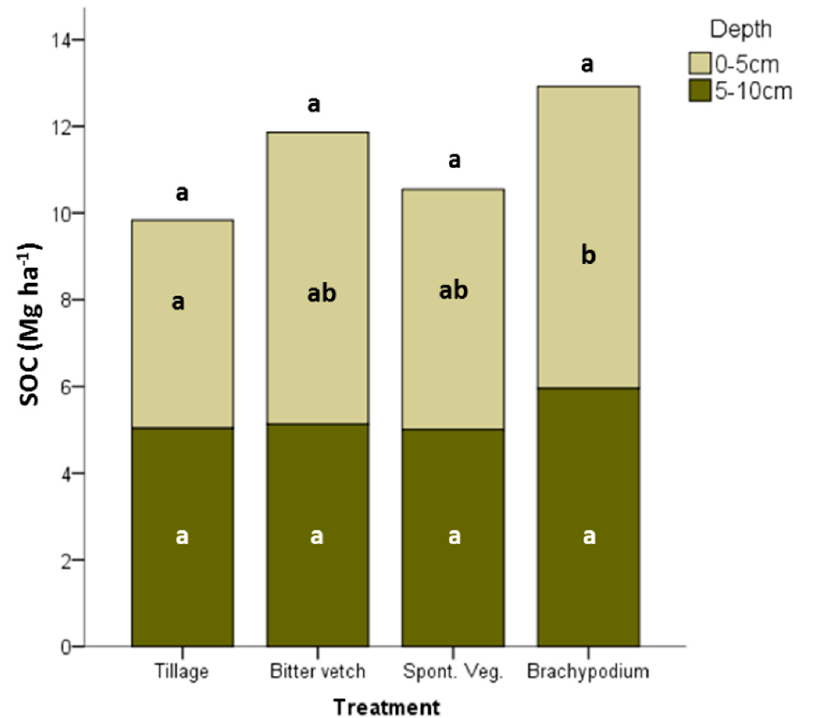
Figure 2. Soil organic carbon stock at 0–5 and 5–10 cm depths in the di ff erent treatments. Di ff erent letters mean significant di ff erences between treatments at p < 0.05 according to Tukey test (N = 12). Di ff erent letters above the bars mean di ff erences between treatments for the SOC content at 0–10 cm depth at p < 0.05 according to Tukey test (N = 12).